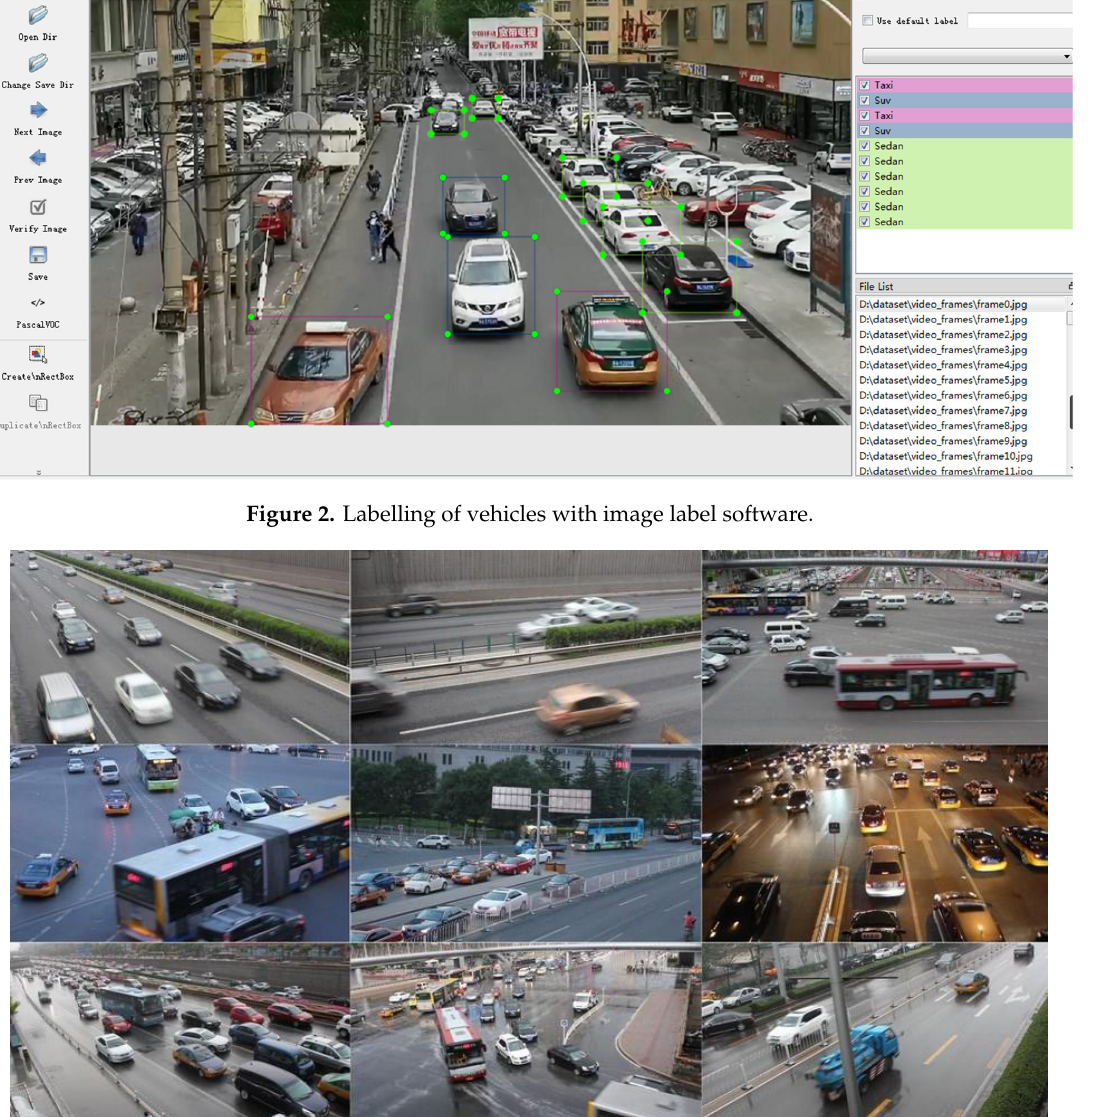
Figure 2. Labelling of vehicles with image label software.